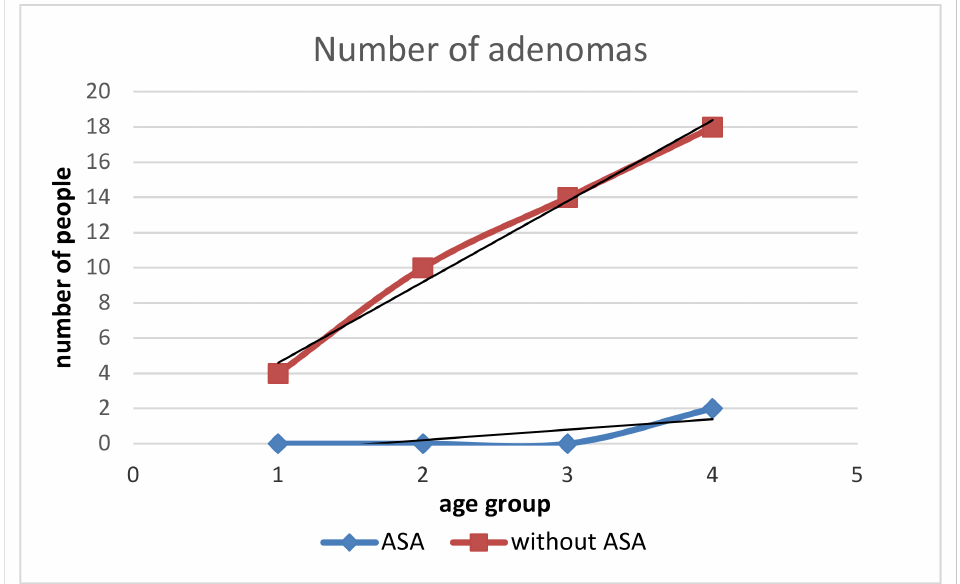
Figure 6. Relationship of adenoma incidence in subjects with ASA and without ASA across age groups. With age, the intensity of adenoma growth decreases, although there is an apparent increase in the number of adenomas in the elderly. Without ASA affects the incidence of more adenomas compared to those with ASA. The curve of adenoma incidence in subjects without ASA can be described by the equation y = 4.6x with a coefficient of determination of